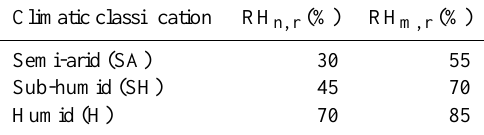
Table 1. Typical values at reference height of daily minimum rela- tive humidity (RH n, r ) and of its daily mean value (RH m, r ) for three types of climate (from Table 16 in FAO-56).